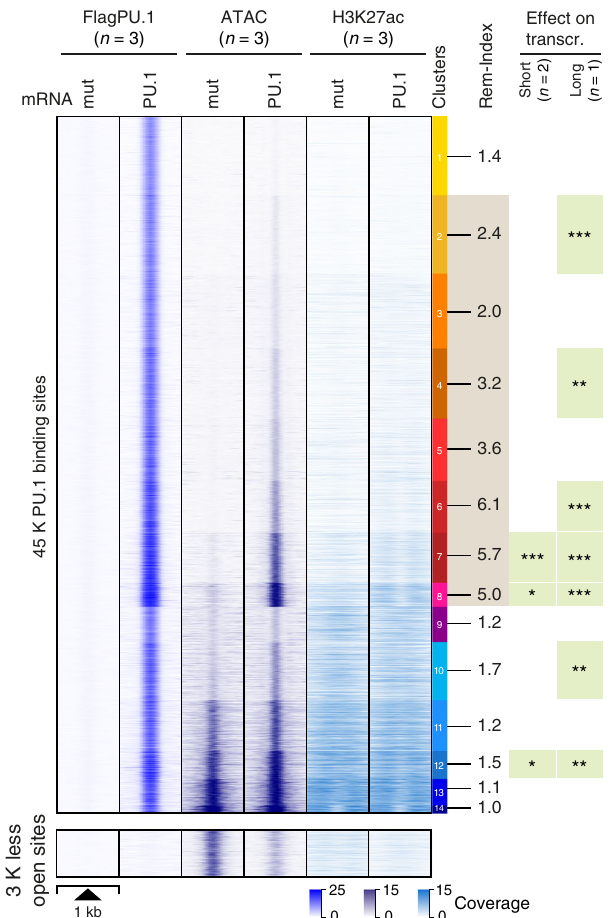
Fig. 3 PU.1-induced changes in chromatin accessibility. The distribution of average PU.1 ChIP-seq, ATAC-seq, and H3K27ac ChIP-seq signals of PU.1 vs. PU.1mut mRNA-transfected cells 8 h after electroporation are plotted across 1 kb windows and 45 K PU.1-binding sites (top panel) or 3 K regions that lost accessibility after PU.1 induction (bottom panel) in CTV-1 cells. PU.1 peaks are ordered according to K-means clustering of peak-centered ATAC-seq signals. PU.1 peak clusters are indicated by the color bar on the right, along with the average remodeling index (Rem-Index) of each cluster. The asterisks on the right indicates the signi fi cant induction of mRNA expression across genes associated with PU.1 peaks in the indicated peak cluster (*** P < 0.001; ** P < 0.01; * P < 0.05; paired Wilcoxon ’ s test) in PU.1- expressing CTV-1 cells. The coloring of PU.1 peak clusters is kept consistent in all following analyses based on the clustering. Source data are provided as a Source Data fi Fig. 3h – k), suggesting that PU.1 operates similarly in different cell types.